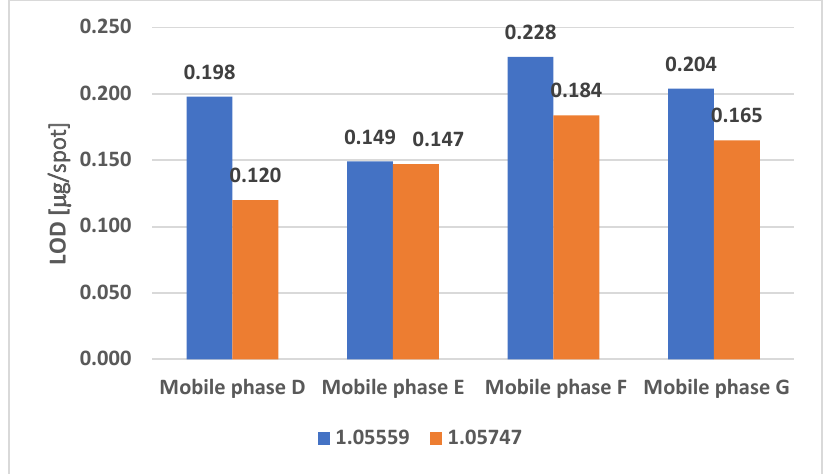
Figure 4. Mean values of the limit of detection for fluoxetine, obtained by partition thin-layer